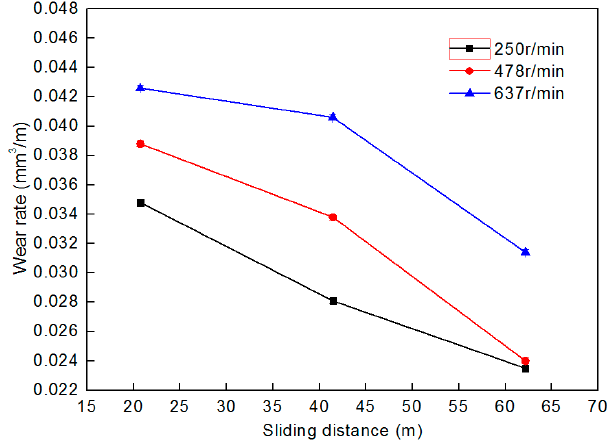
Figure 7. Wear rate of UIRP samples under different sliding speeds and sliding distances.